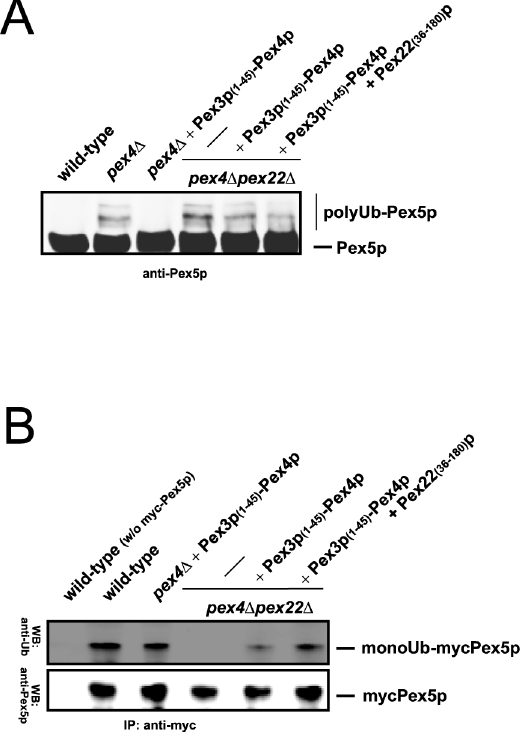
Figure 4. Pex22(C)p reduces polyubiquitination and stimulates monoubiquitination of the PTS1-receptor Pex5p invivo . ( a ) It is known that the inhibition of the export of Pex5p by the deletion of PEX4 and/or PEX22 induces polyubiquitination and proteasomal degradation of Pex5p. The PEX4/PEX22-deletion induced polyubiquiti- nation of Pex5p can be significantly reduced when the cells express Pex3(N)-Pex4p in combination with Pex22(C)p. ( b ) The Pex3(N)-Pex4p chimera is capable to monoubiquitinate Pex5p in vivo . The level of monoubiquitinated Pex5p is reduced in the absence of Pex22p, but is restored in the presence of